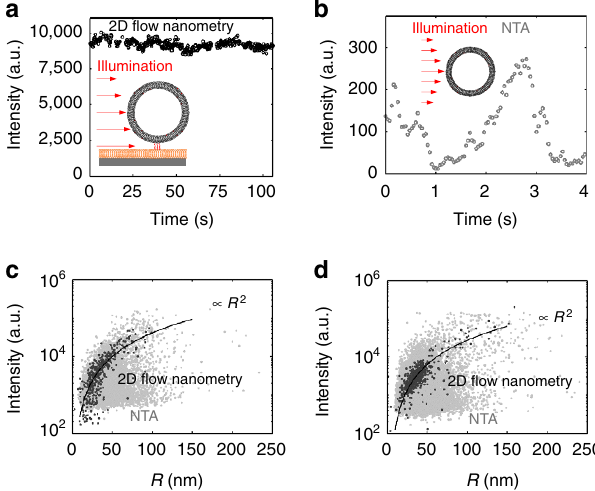
Figure 5 | Comparison of vesicle intensity extraction done by 2D flow nanometry and NTA. a and b show representative intensity traces for a single, fluorescently labelled vesicles, while c and d compare the intensity- versus-size parameter plots obtained by NTA (grey dots) and 2D flow nanometry (black dots) for two different batches of SUVs (created by sonication ( c ) and extrusion ( d ) as described in the ‘Methods’ section). Both batches show peak hydrodynamic radii around 38nm, but differ in their polydispersity. Due to much lower intensity fluctuations observed in 2D flow nanometry ( a ) with respect to NTA ( b ), the expected scaling law is well visible in the parameter plots (solid lines in c , d ), while it is hard to resolve for NTA